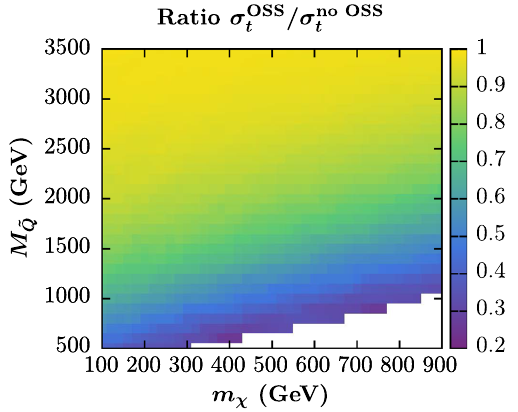
Fig. 5 Impact of the subtraction of on-shell resonances in the real- emission contributions to DM pair production in the t -channel model. Shown is the ratio of the total cross section at NLO QCD with the subtraction of on-shell contributions ( σ OSS t ) to the case ( σ no OSS t ) where the on-shell resonances are not subtracted, but regularised by a finite width only. The axes of the plot are chosen as the DM mass m χ and the average t -channel mediator mass M ˜